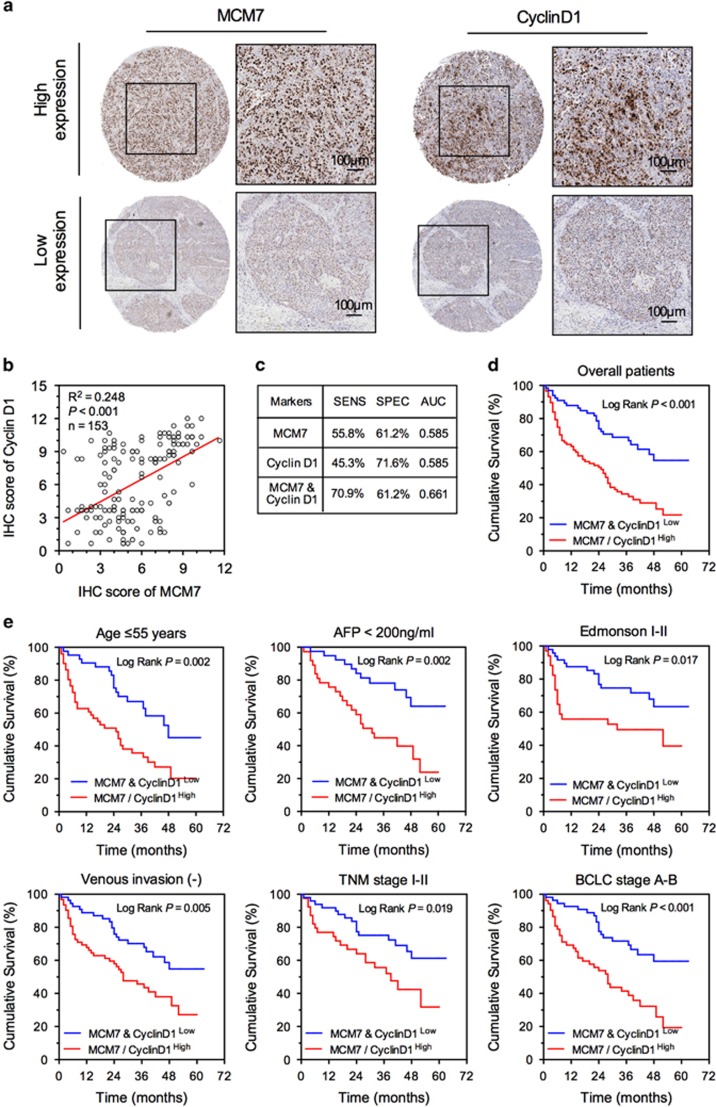
MCM7 and cyclin D1 served as potential biomarkers for prognosis of HCC. (a) Representative IHC staining of MCM7 and cyclin D1 in the same HCC tissue, bar=100 μm. (b) Linear correlation analysis of MCM7 and cyclin D1 expression in HCC tumor tissues. (c) Diagnostic test evaluations of either MCM7 or cyclin D1 alone or in combination in predicting the risk for patients' death. Prognostic value of combination of MCM7 and cyclin D1 in overall HCC patients (d) and different subgroups (e)